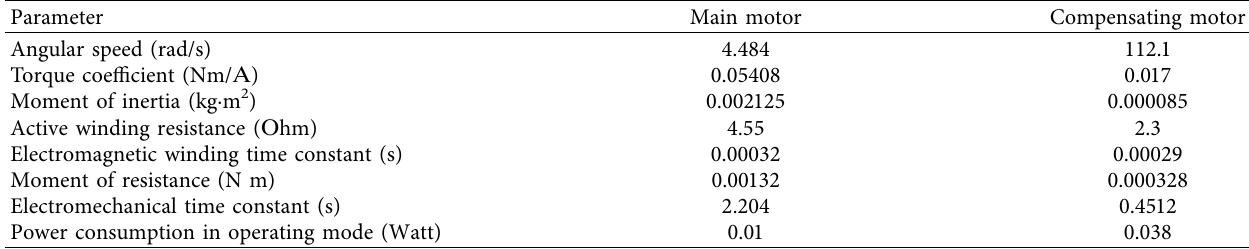
Table 1: The main technical characteristics of main and compensating motors.